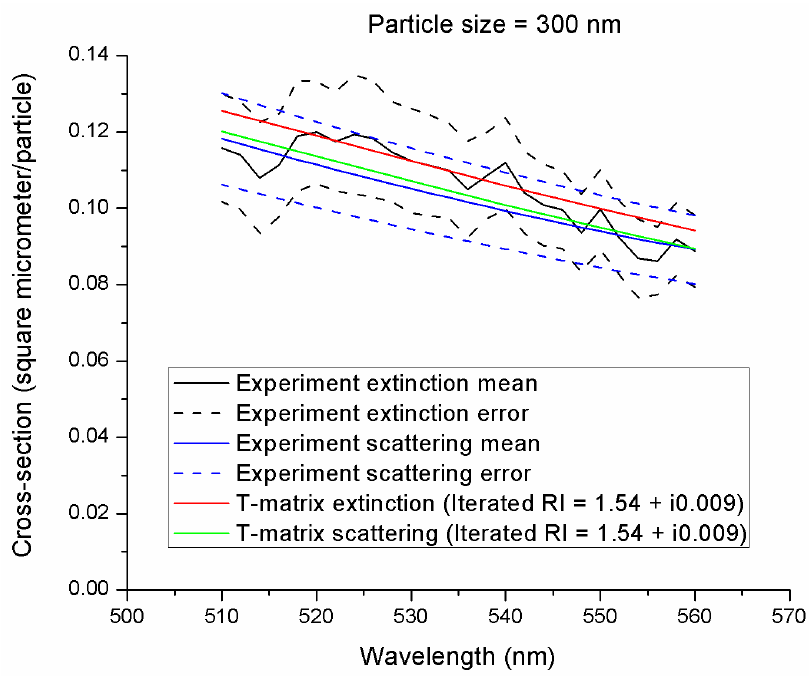
Figure 9. Experimental and calculated values of the extinction and scattering cross-sections for 300-nm particles.